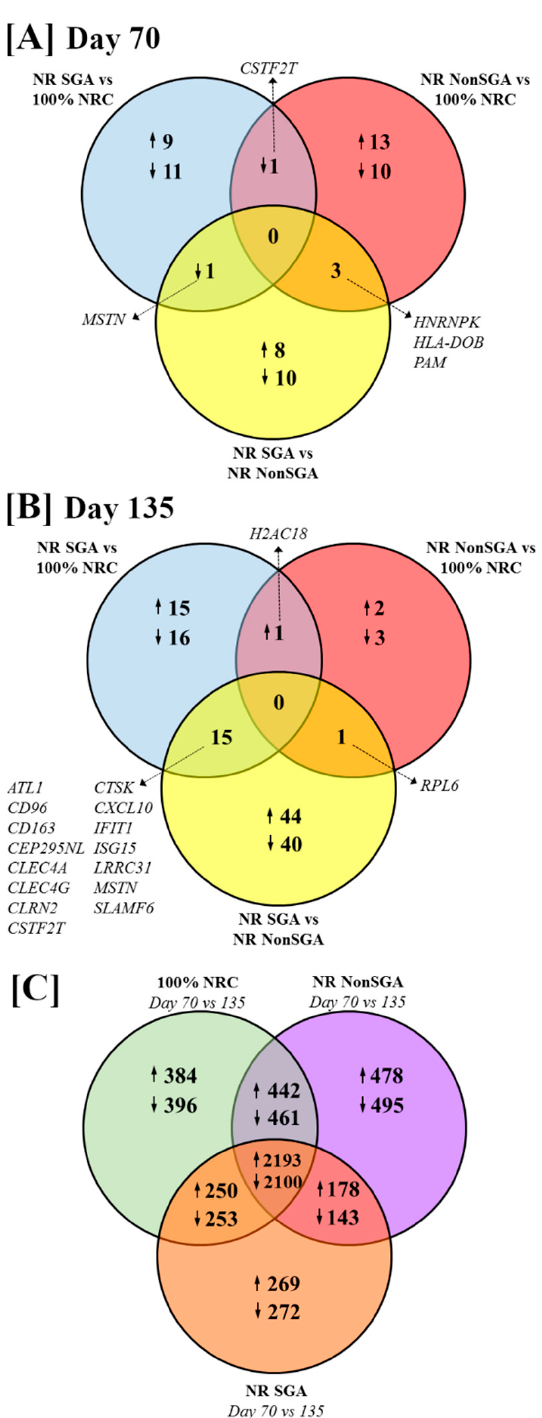
Figure 1. Venn diagrams depicting differentially expressed genes (DEGs) between 100% NRC ( n = 8), NR NonSGA ( n = 7), and NR SGA ( n = 7) placentomes at day 70 ( A ) and day 135 ( B ) of gestation. The number of DEGs between day 70 and day 135 within each treatment group is depicted in ( C ). Genes were considered differentially expressed when FDR ≤ 0.10 and p ≤ 0.05. Table 1. Differentially expressed genes in placentomes at day 70 of pregnancy.